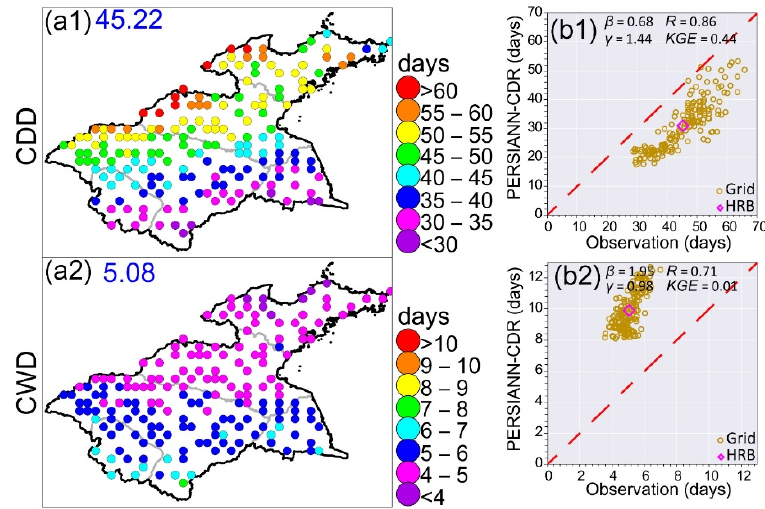
Figure 5. Spatial patterns of multi-year annual means of observational duration-based indices and the scatterplots between observation and PERSIANN-CDR. a1 , a2 ( b1 , b2 ) are for CDD and CWD, respectively. In a1 , a2 , the blue numbers represent the HRB mean for a given extreme precipitation index. The red dashed line in b1 , b2 is the 1:1 line.